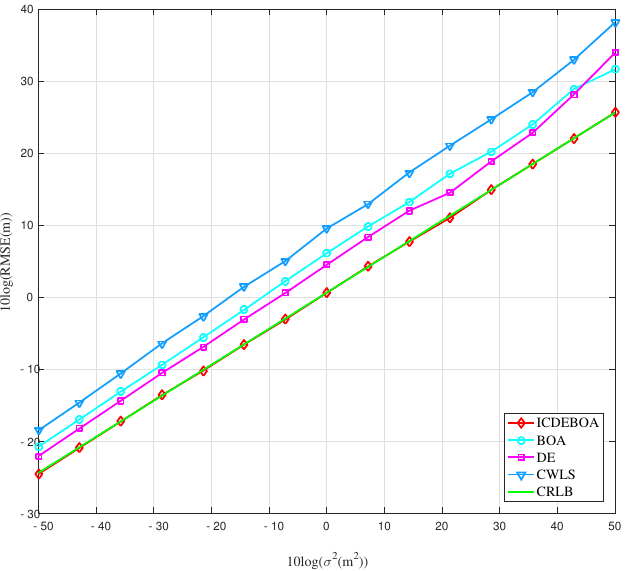
Figure 6. The results obtained for the third simulation case depicted in the form of RMSE performance of different algorithms vs. p